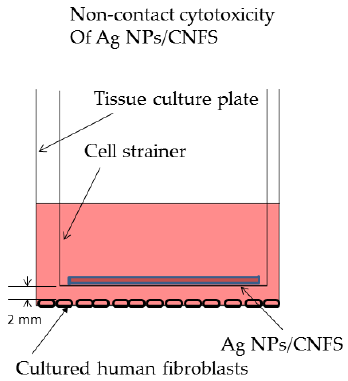
Figure 2. Scheme of experiments on noncontact cytotoxicity of Ag NPs/CNFS (for Figure 3). The fibroblasts were cultured on a 6-well tissue culture plate in 2.5 mL of Dulbecco’s modified Eagle Medium (DMEM) containing 10% FBS for 2 days. Either Ag NPs/CNFS or CNFS alone was placed on a round cell-strainer.